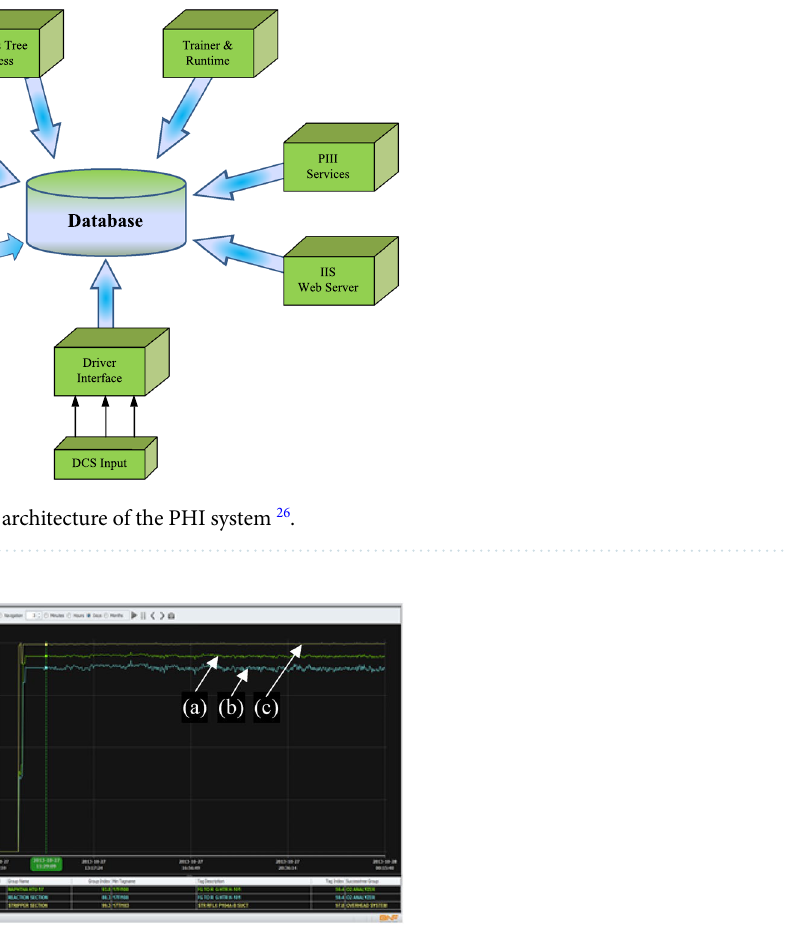
Figure 12. Example display of the PHI indicating the ( a ) overall plant health index and the health indices of the ( b ) reaction and ( c ) stripper